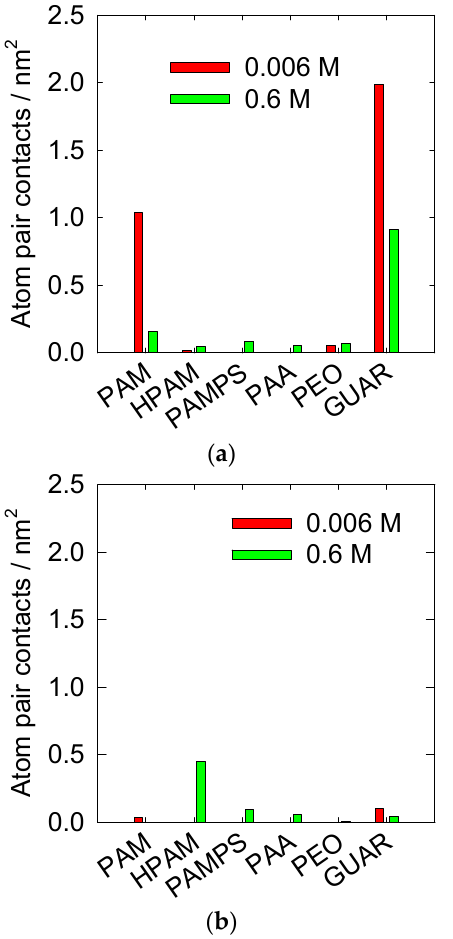
Figure 2. Comparison of quartz (101) and kaolinite surfaces (010) at pH 7 at 300 K. ( a ) Quartz (Reprinted/adapted with permission from Ref. [31]. Copyright (2022), Elsevier) and ( b ) kaolinite (This